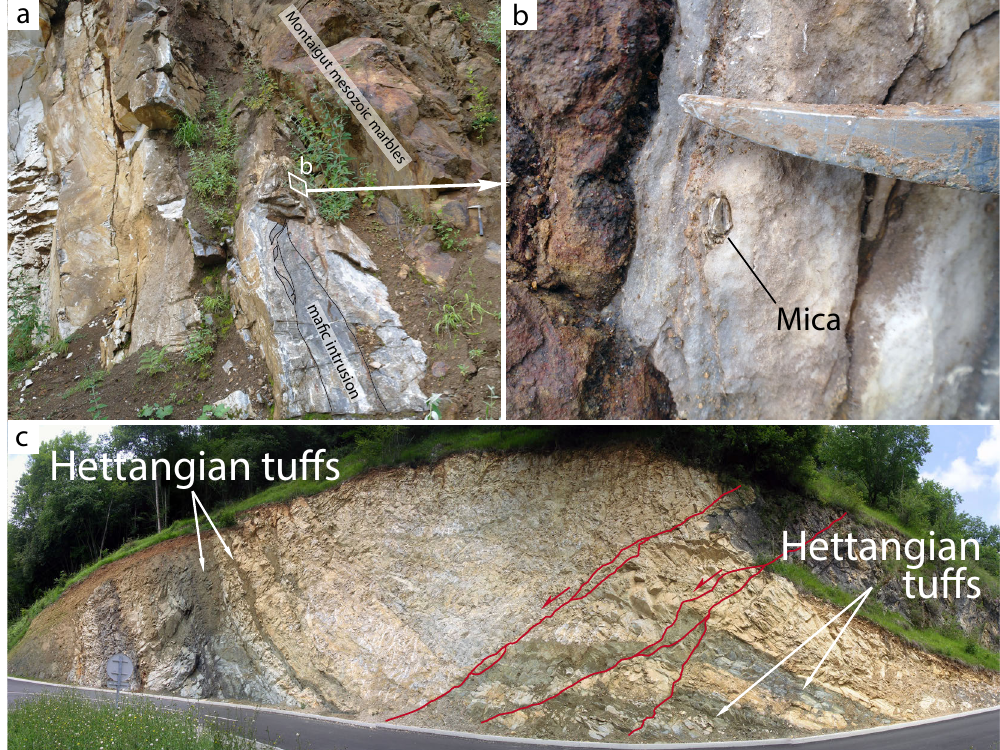
Figure 10. (a) Boudinaged sill in the Montégut marble quarry; (b) detail of (a) showing centimetric muscovite at the contact (sample 11MP92b); (c) two beds of Early Jurassic tuffs intruding marbles at the new outcrop of road D39 (samples 11MP86 and